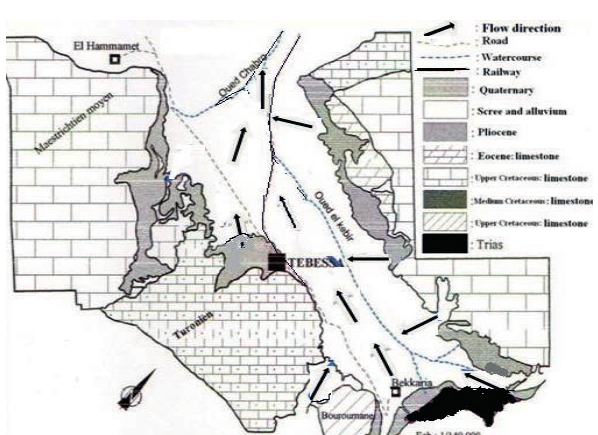
Fig. 1 Location of the study area.